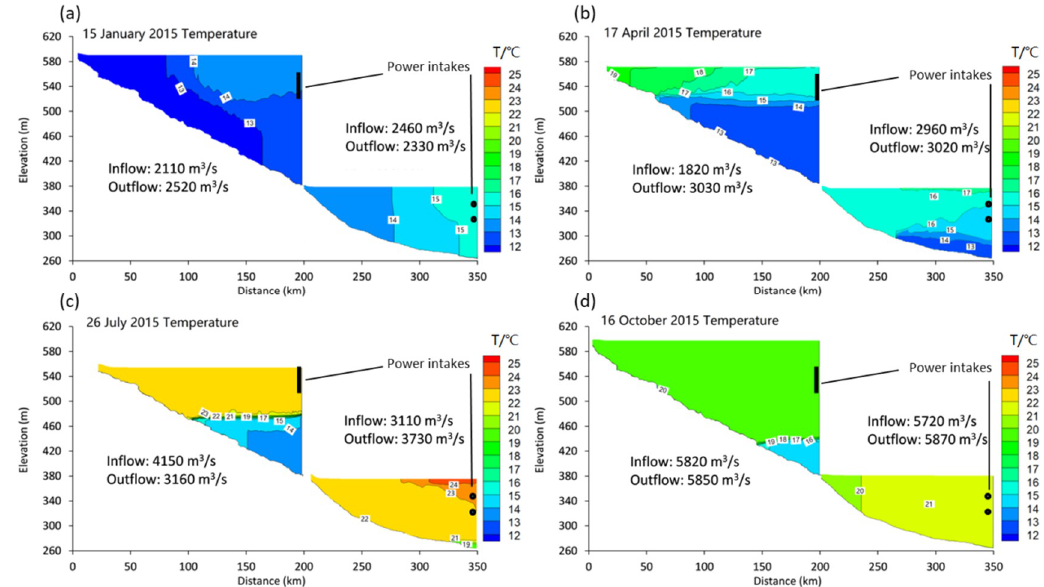
Figure 6. Simulated vertical and longitudinal distribution of water temperature in Xiluodu and Xiangjiaba reservoirs during ( a ) winter, ( b ) spring, ( c ) summer, and ( d ) autumn 2015. The location of the turbine intakes as well as in and outflow rates are indicated by labels.